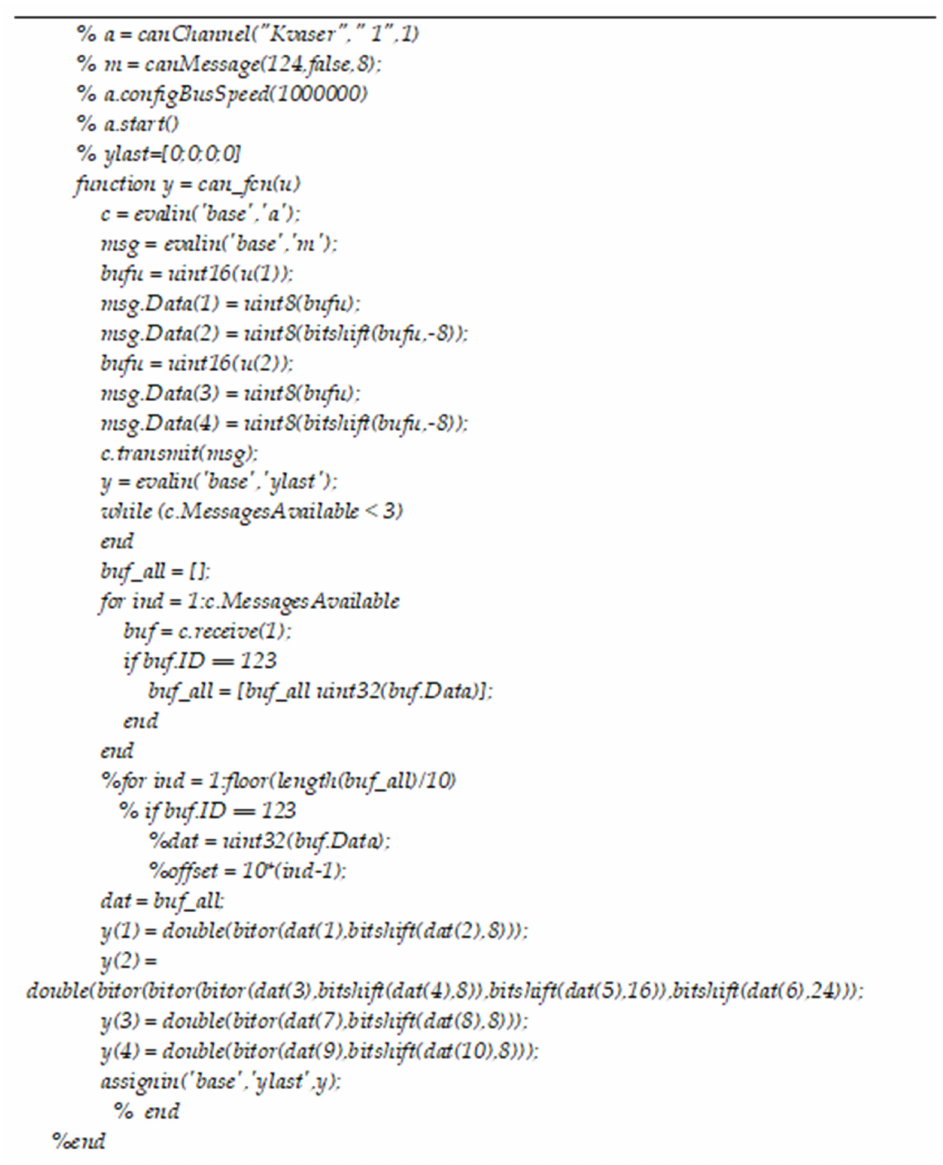
Figure 12. Structure of closed-loop system with H ∞